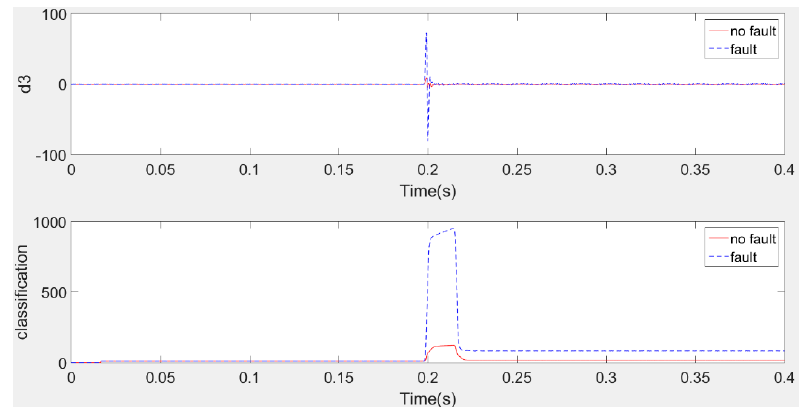
Figure 13. D3 coefficient and new index at bior3.1 MW.